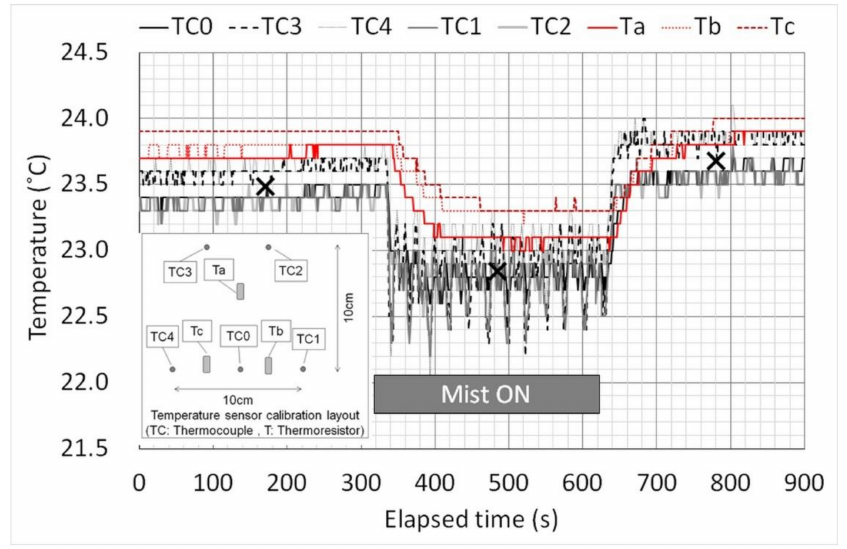
Figure 2. Example of misting fan and heater characterization temperature measurements. Here, misting without a heater. Sensor positions shown in insert at lower left.